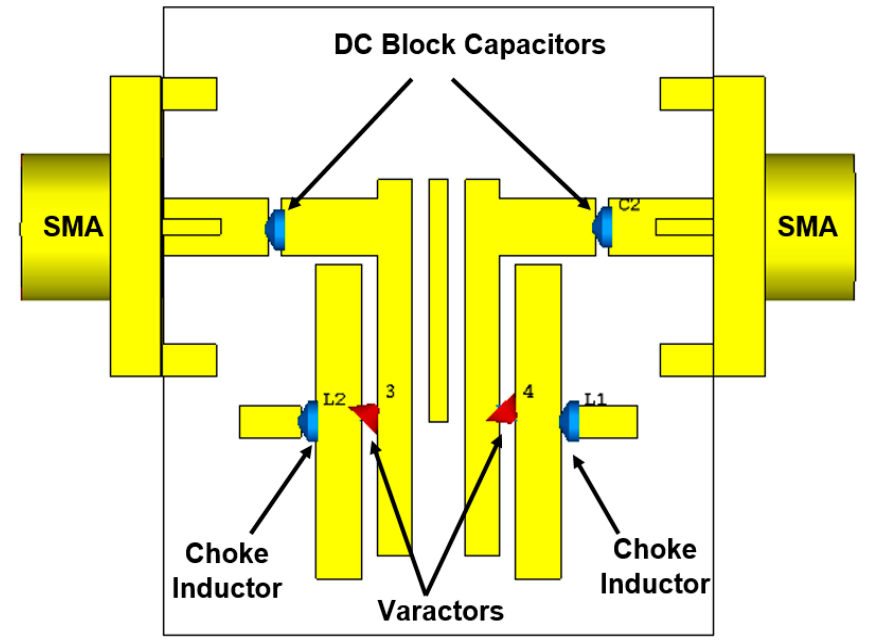
Figure 7. The proposed reconfigurable microstrip planar BPF configuration with DC biasing circuit elements.